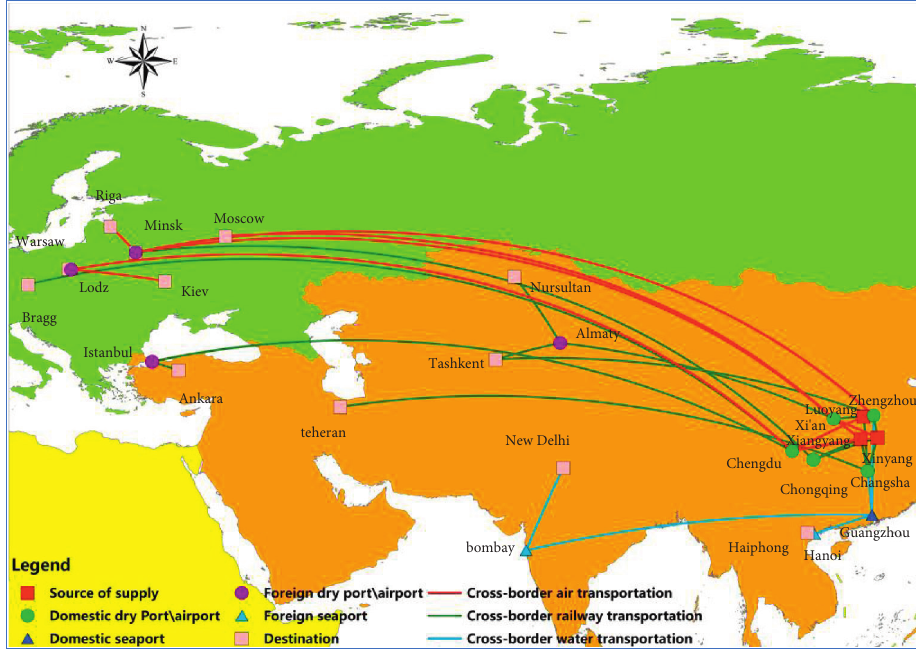
Figure 9: The optimal cross-border logistics paths in central region.